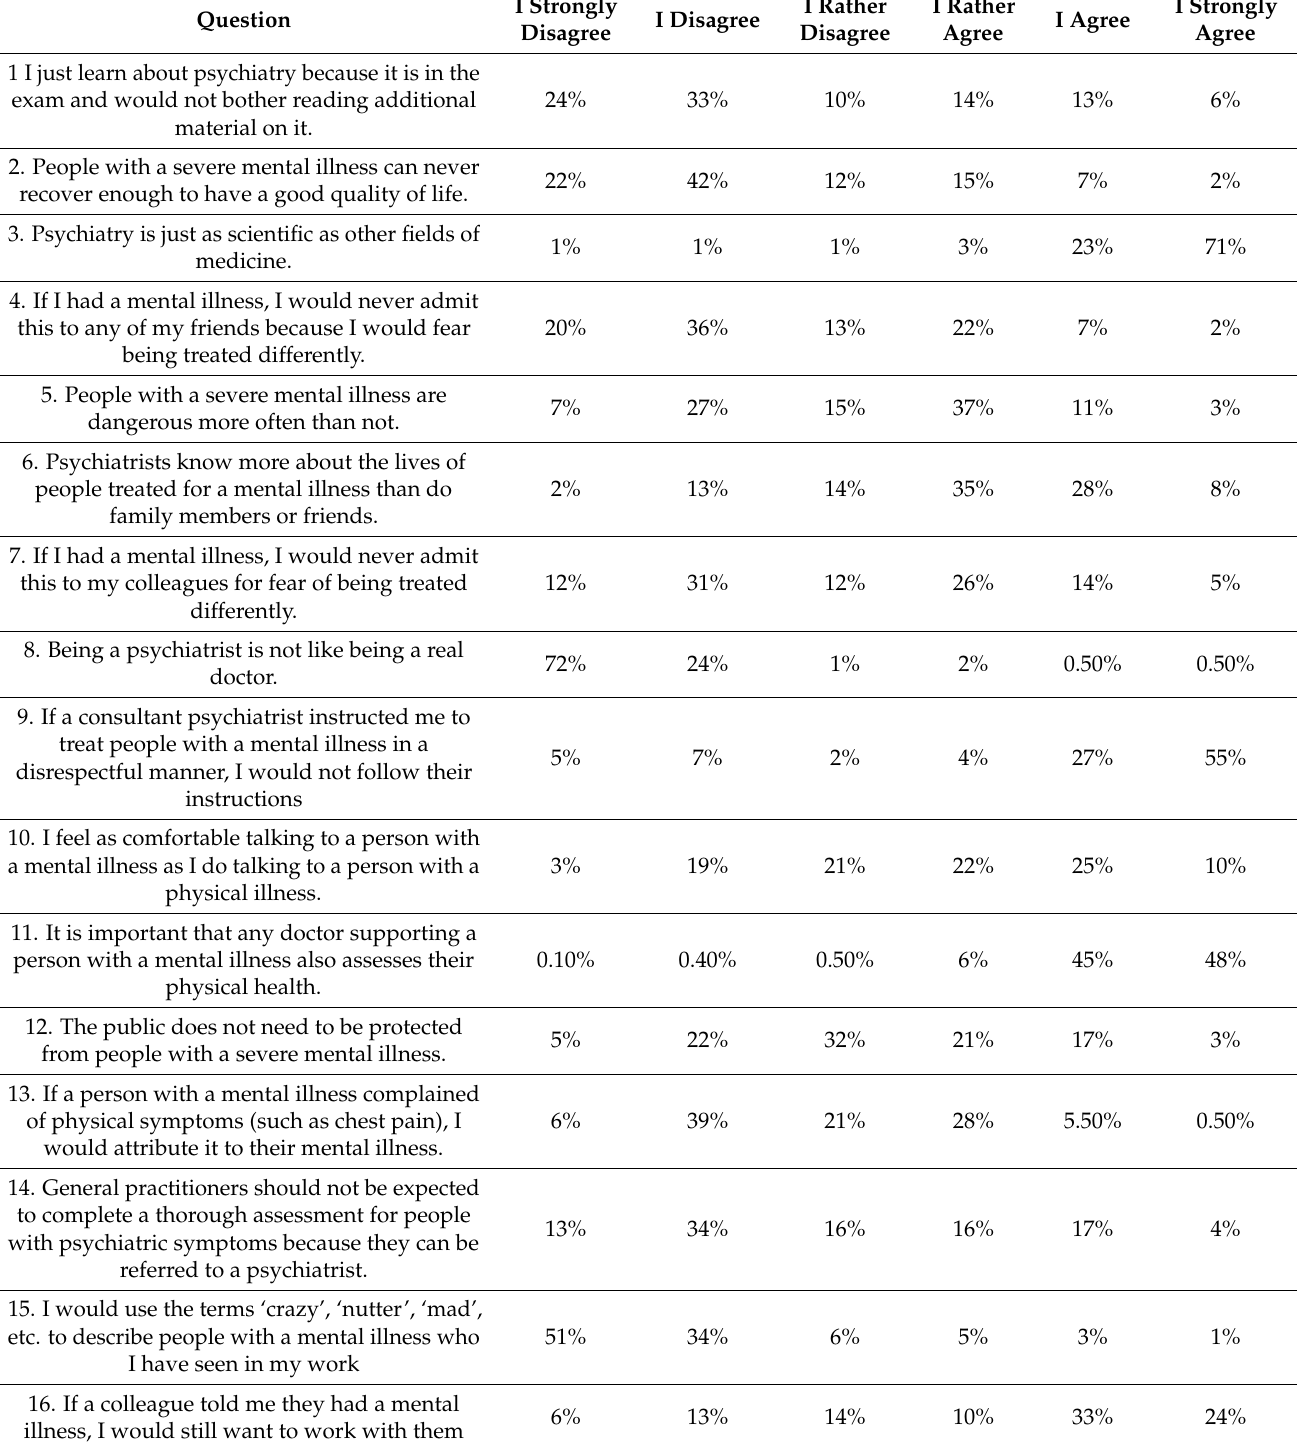
Table 4. The analysis of individual questions addressed in the MICA-2 questionnaire. Question